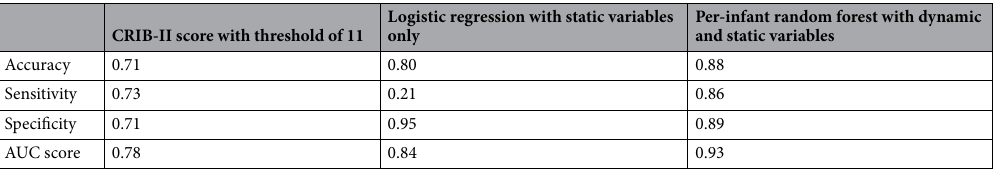
Per-infant random forest with dynamic and static